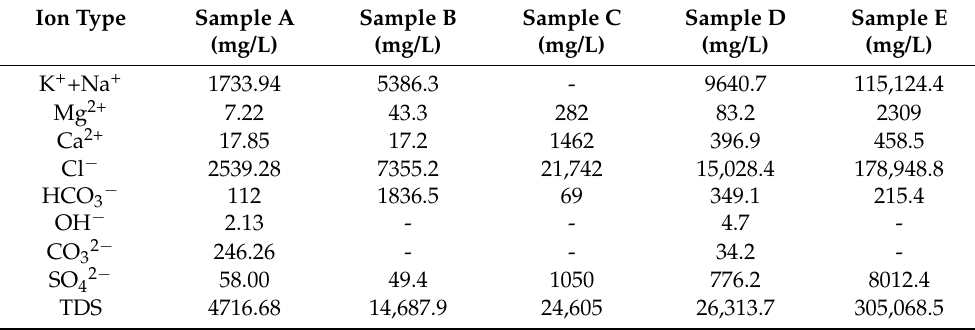
Table 1. Composition of flowback and produced water